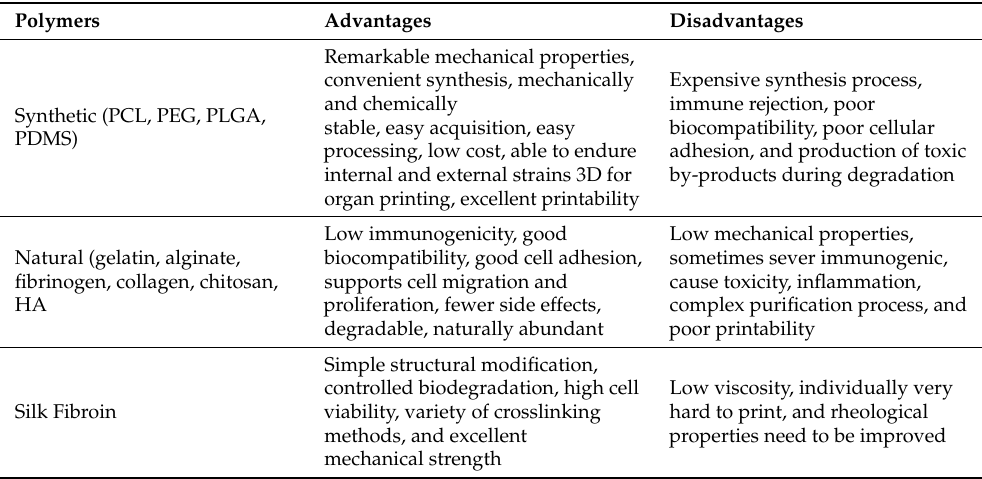
Table 2. Comparison of SF polymers with natural and synthetic polymers based on their major advantages and disadvantages [15,18,23–26,29–31]. Polymers Advantages Disadvantages Synthetic (PCL, PEG, PLGA, PDMS) Natural (gelatin, alginate, fibrinogen, collagen, chitosan,